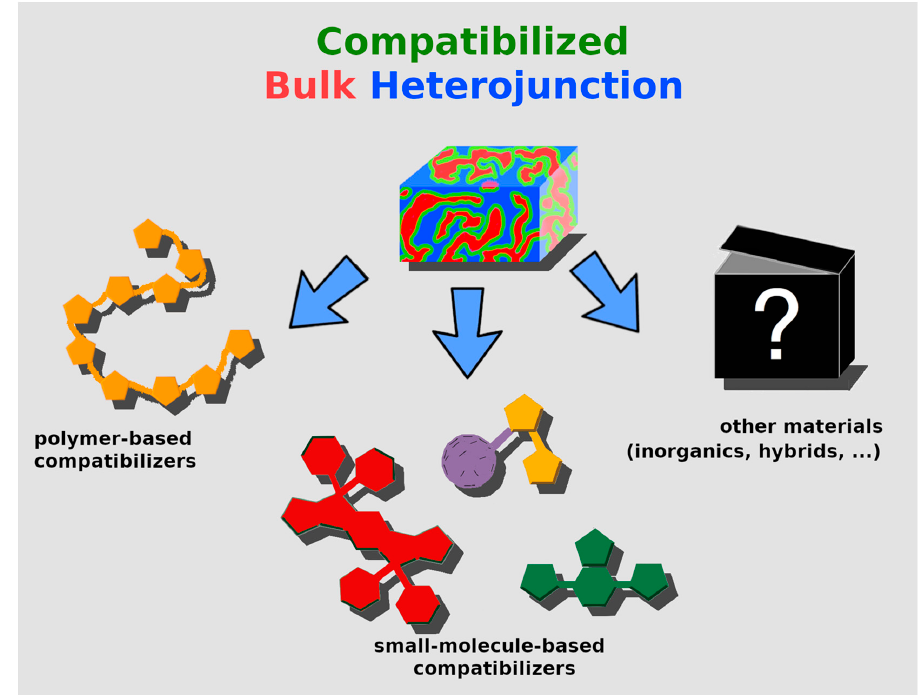
Figure 3. Different classes of CB-materials tested for improving the performance of BHJ-based de- vices.